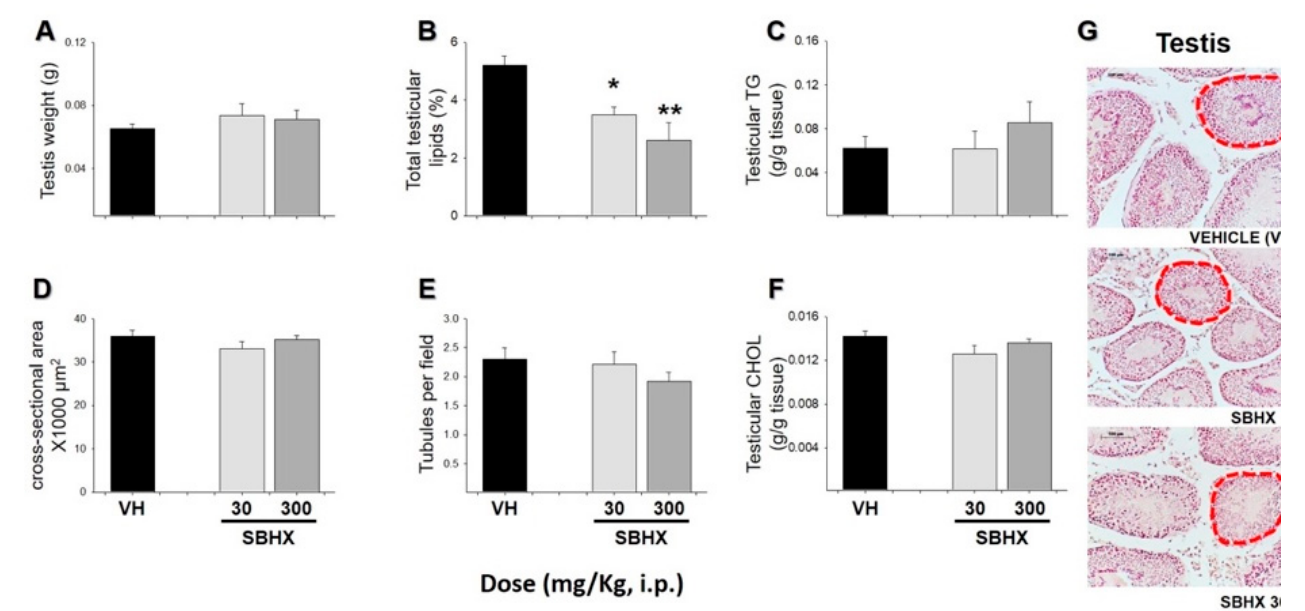
Figure 3. Histological and biochemical analysis of mice testicular tissue receiving SBHX (30 or 300 mg/kg, i.p.) and compared to the vehicle group (VH). Testis weight (g) ( A ), total testicular lipids (%, determined by the Folch method) ( B ), testicular triglycerides (TG, g/g testis) ( C ), seminiferous tubule cross-sectional area (×1000 μ m 2 ) ( D ), number of seminiferous tubules per field (25 fields observed per treatment) ( E ), testicular cholesterol (CHOL) ( F ). Representative microphotographs of seminiferous tubules taken with a light-field microscope with 40× magnification ( G ). Data represent the mean ± SEM of five mice ( n = 5). * p < 0.05 or ** p < 0.01, ANOVA followed by Dunnett’s test.